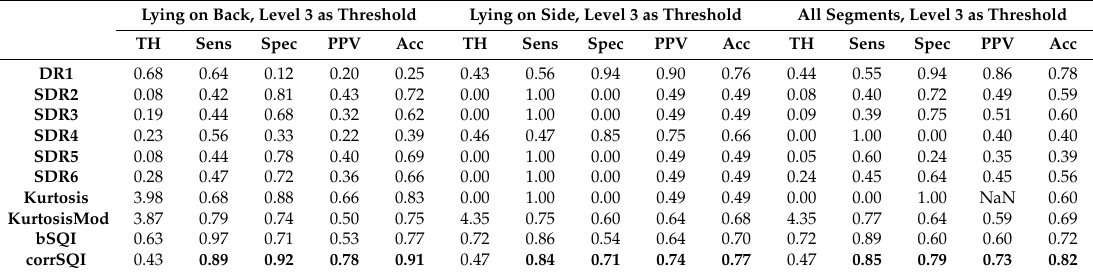
Table 5. Test results for segment classification into usable or not usable ccECG considering level 3 as threshold for usable signal.